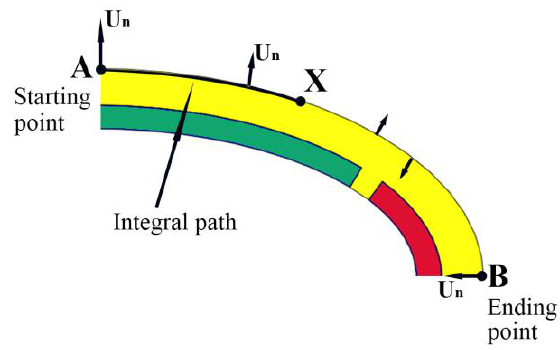
Figure 5. Schematic of volume displacement calculations.